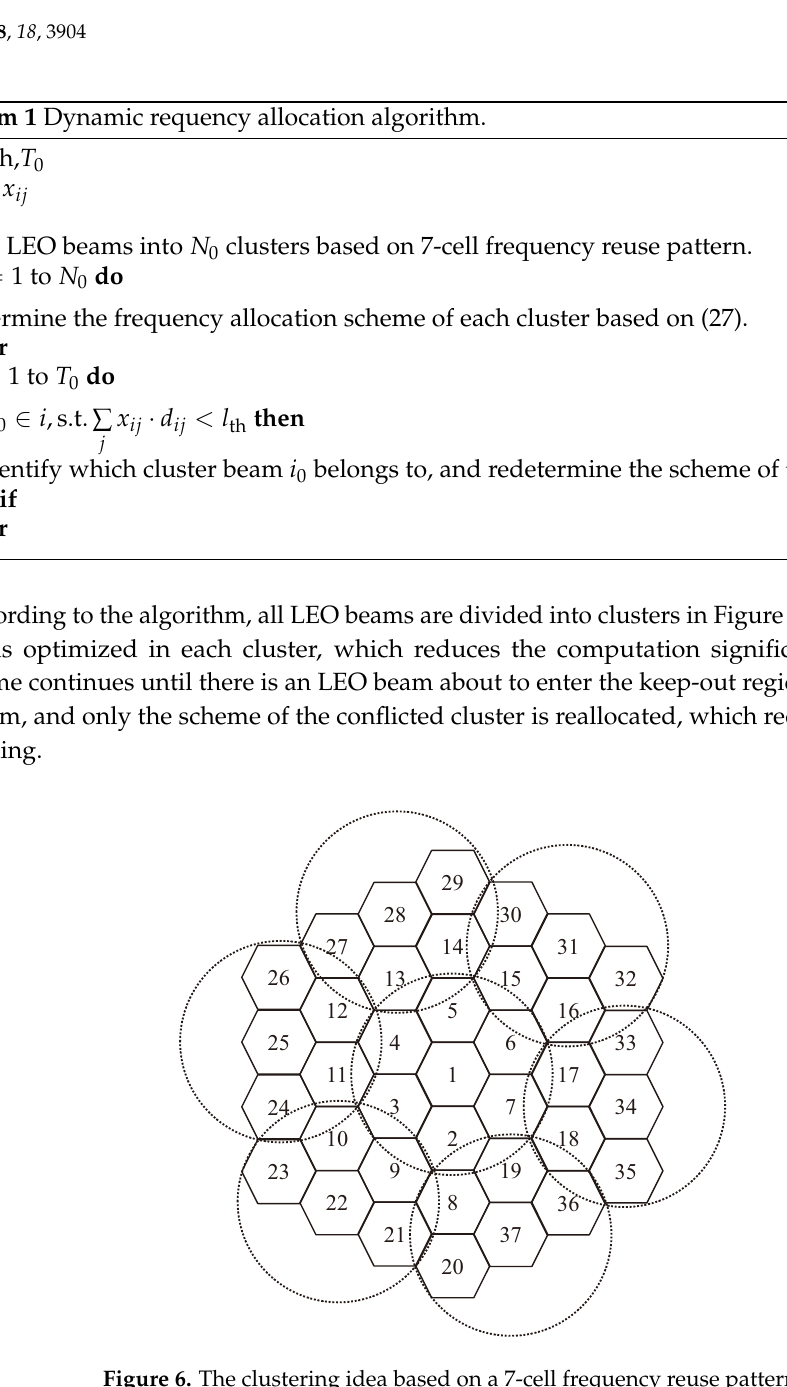
Figure 6. The clustering idea based on a 7-cell frequency reuse